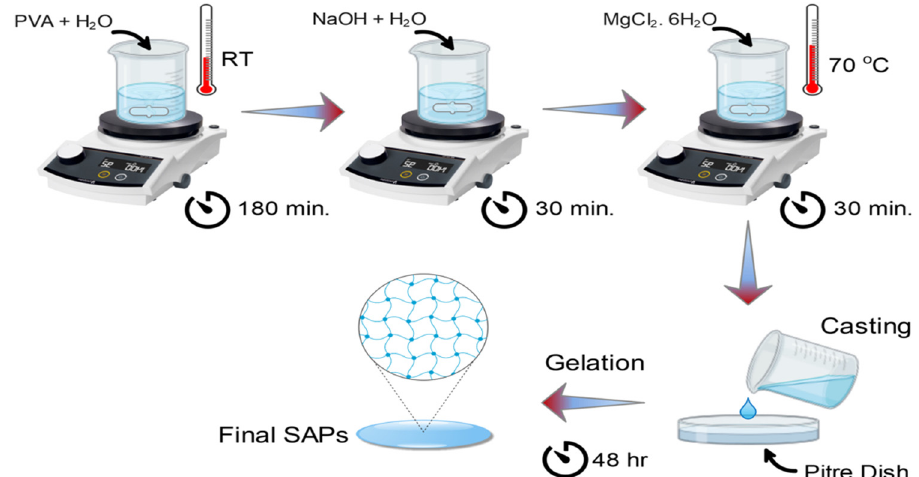
Figure 3: The preparation steps of Mg - PVA SAPs.